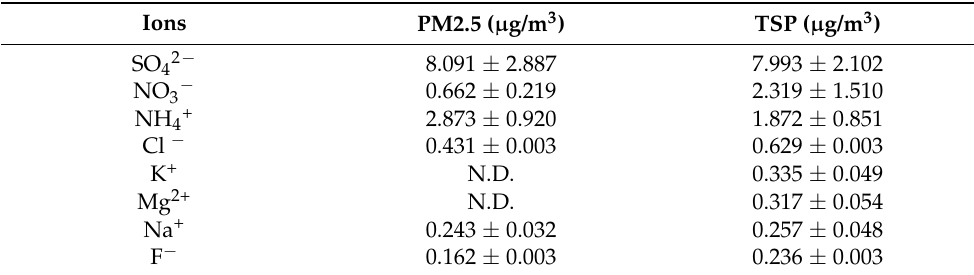
Table 2. Concentrations of ion in PM2.5 and TSP.